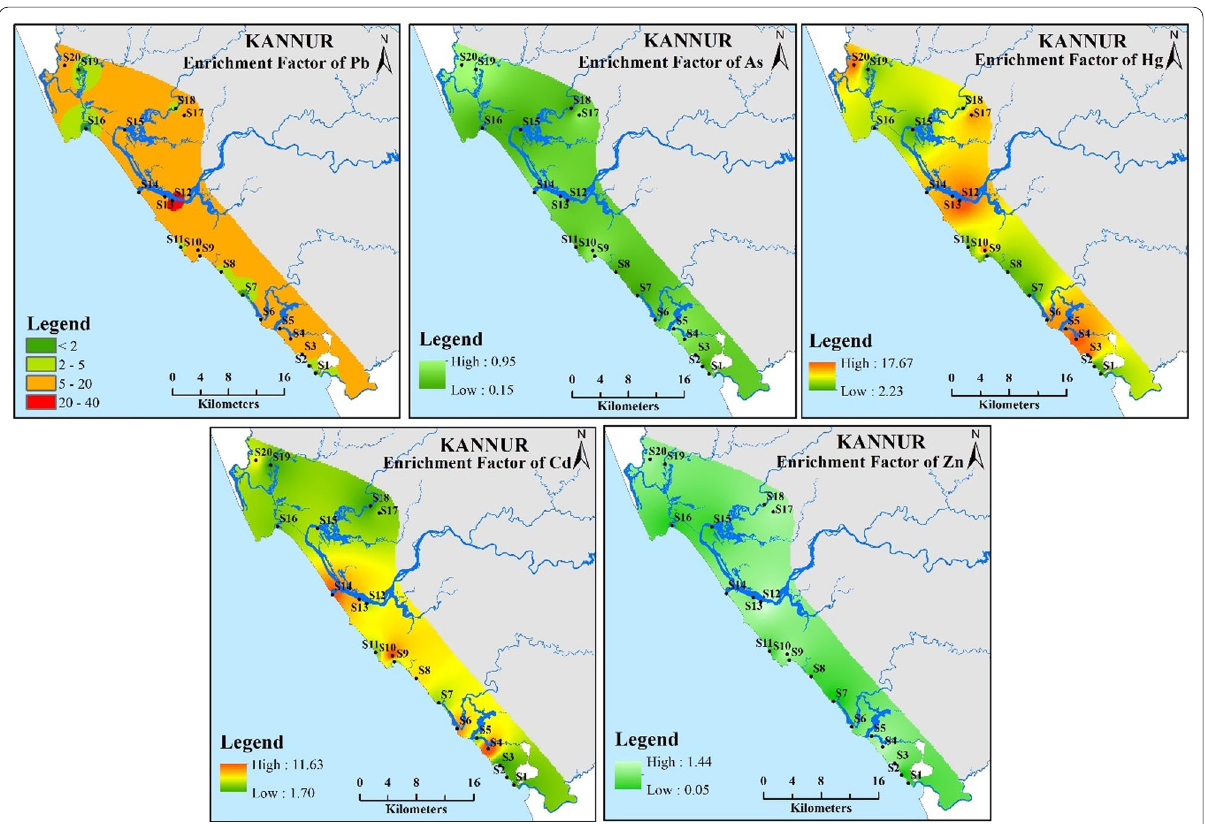
Fig. 4 Spatial distribution of enrichment factor of heavy